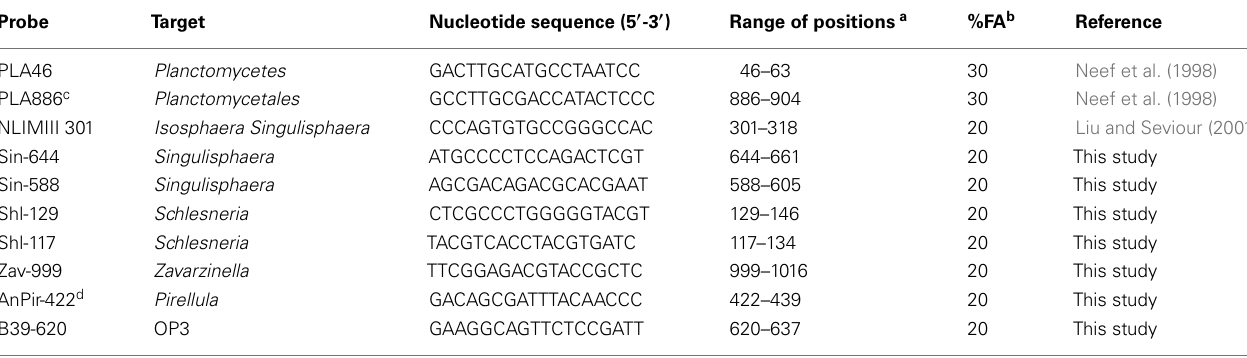
Table 2 | Planctomycete-specific FISH probes used in this study.